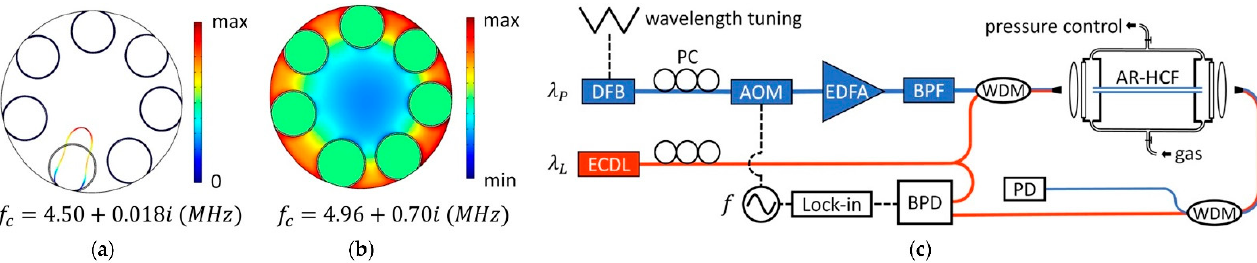
Table 2. Comparison of the performance of the ARHCF-based gas